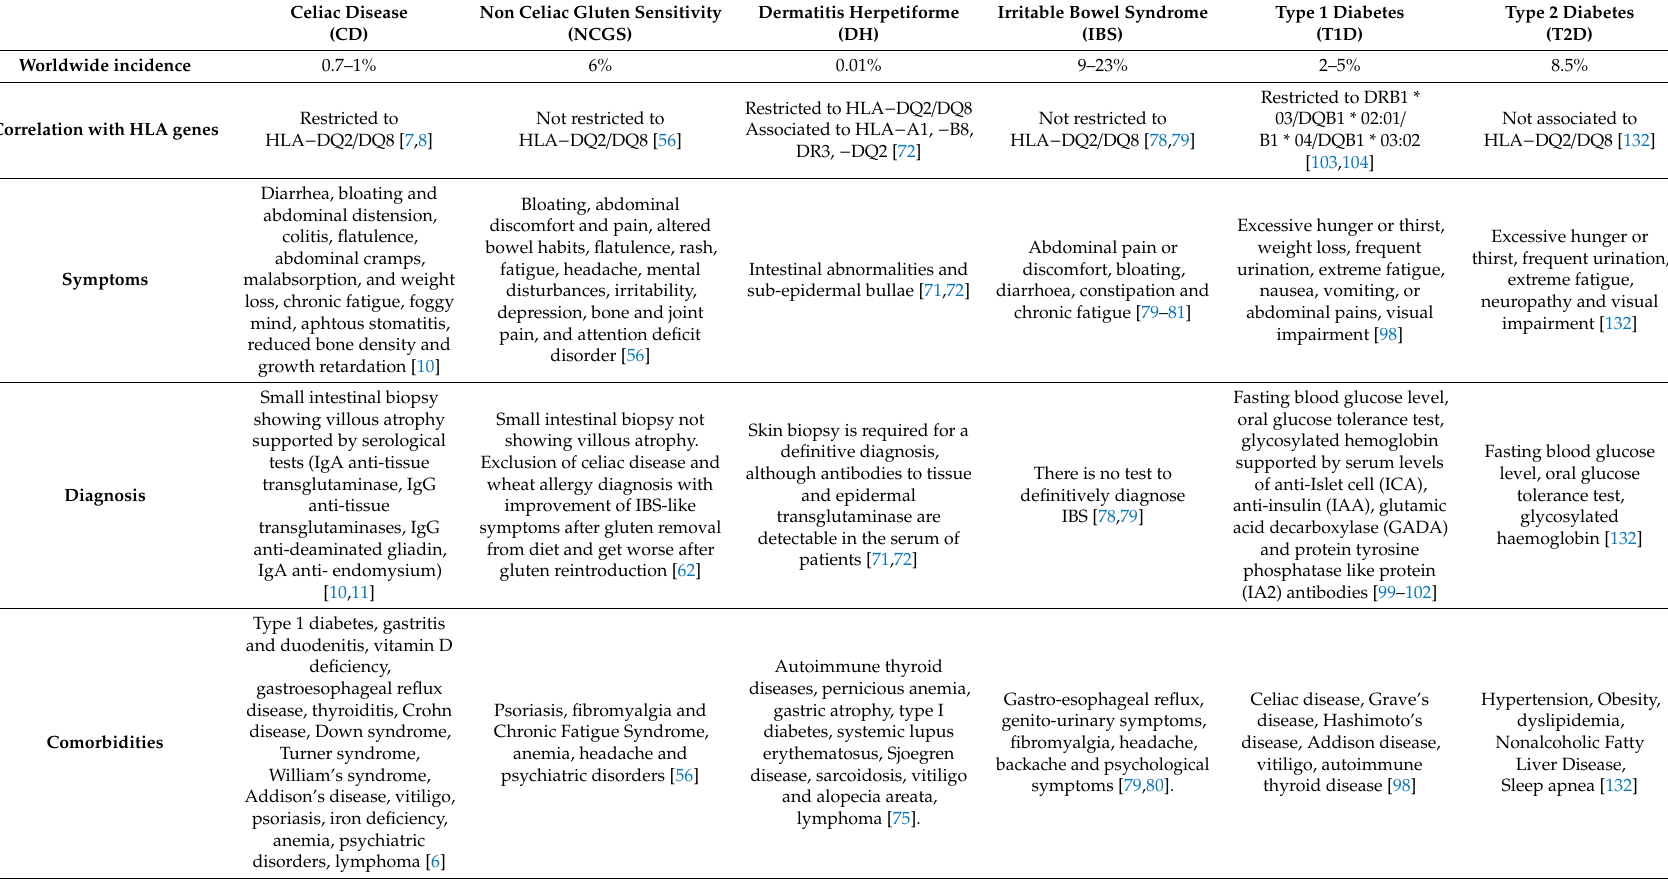
Table 1. Di ff erent pathological conditions associated with Gluten